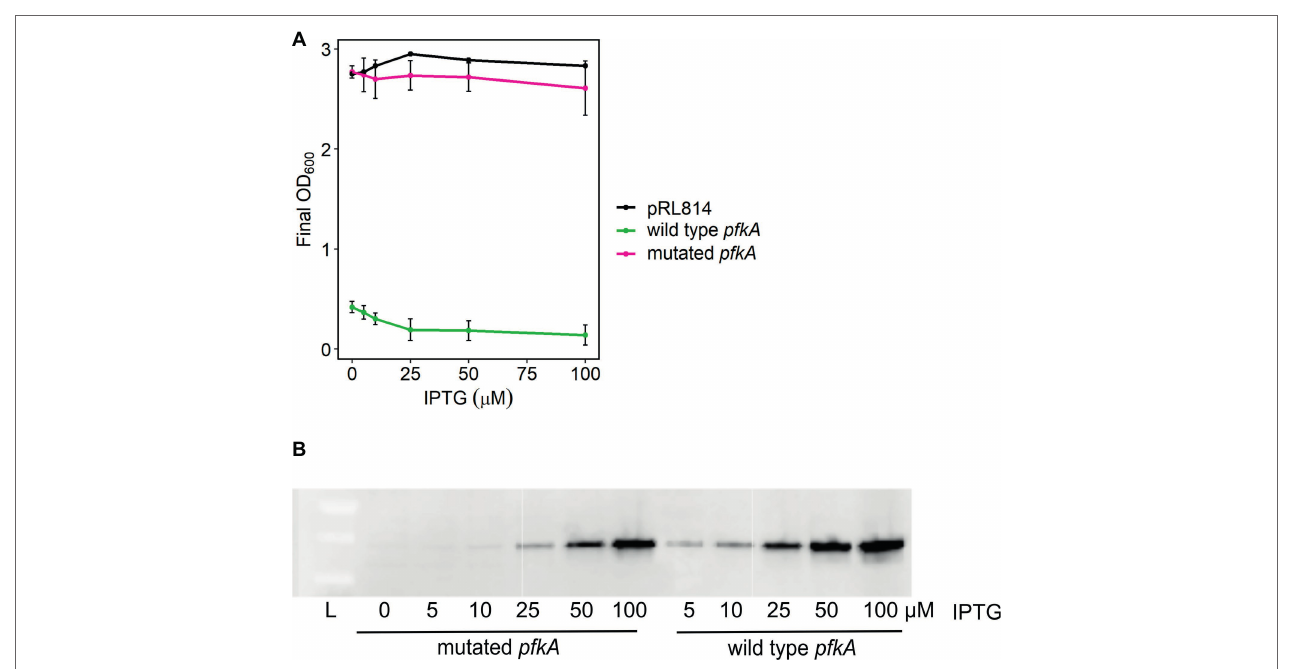
FIGURE 2 | Growth of Z. mobilis bearing pRL pfkA. (A) Cultures were inoculated from glycerol stocks of slow or fast growing isolants of ZM4 bearing pRL pfkA and were grown overnight, aerobically, in rich medium with spectinomycin and indicated concentrations of IPTG. Average OD 600 and standard deviations are from three biological replicates. (B) Whole cell lysates from overnight cultures in (A) were analyzed by Western blot. Equivalent of 1 ml at OD 600 = 0.006 per lane was analyzed. Proteins were detected with anti-FLAG antibody. A representative blot is